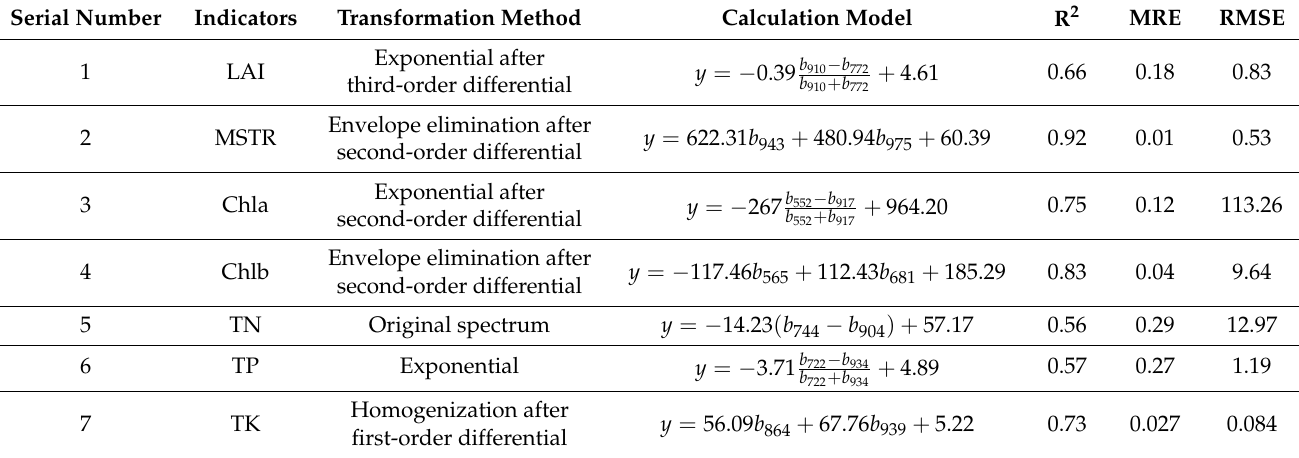
Table 3. Calculation model and precision evaluation results of mangrove key